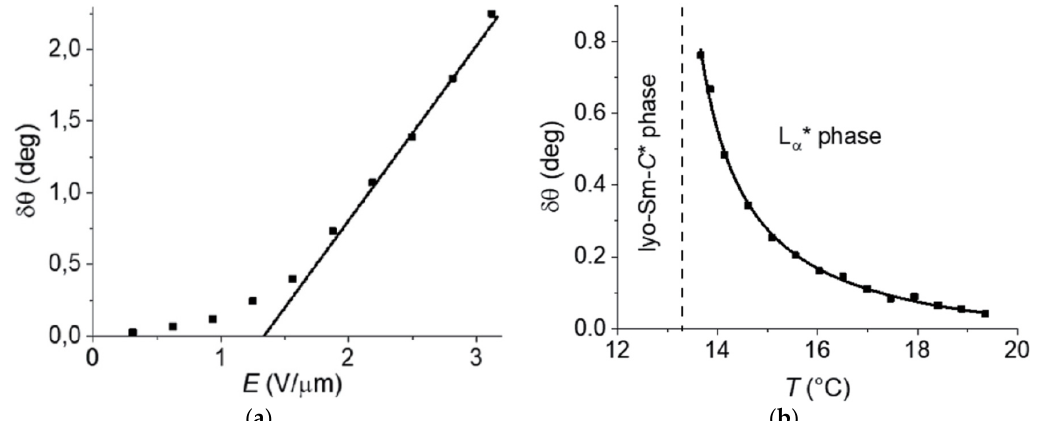
Figure 25. Signatures of the electroclinic effect in the L 𝛼 * phase of the chiral amphiphile 4 with 23 wt.% of formamide. ( a ) Electroclinically induced tilt angle δθ versus amplitude E of a 400 Hz square-wave electric field at a fixed temperature of 0.5 K above the transition temperature into the lyo-SmC* phase. The straight line shows the linear regime of δθ ( E ). ( b ) δθ versus temperature T at a fixed amplitude E = 1.9 V/µm of the 400 Hz square-wave electric field. The solid line shows the Curie–Weiss-like hyperbolic divergence of δθ ( T ). (Reprinted by permission from [69] Copyright 2018 by the American Physical Society.)